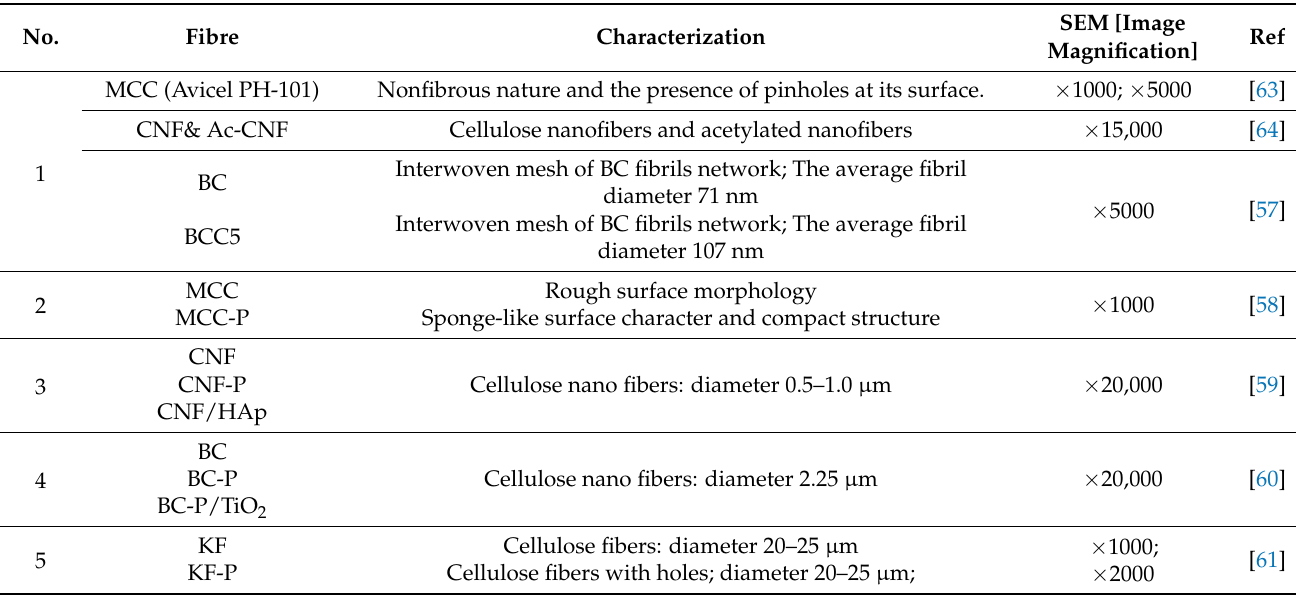
Table 4. Morphology of various cellulose types and their